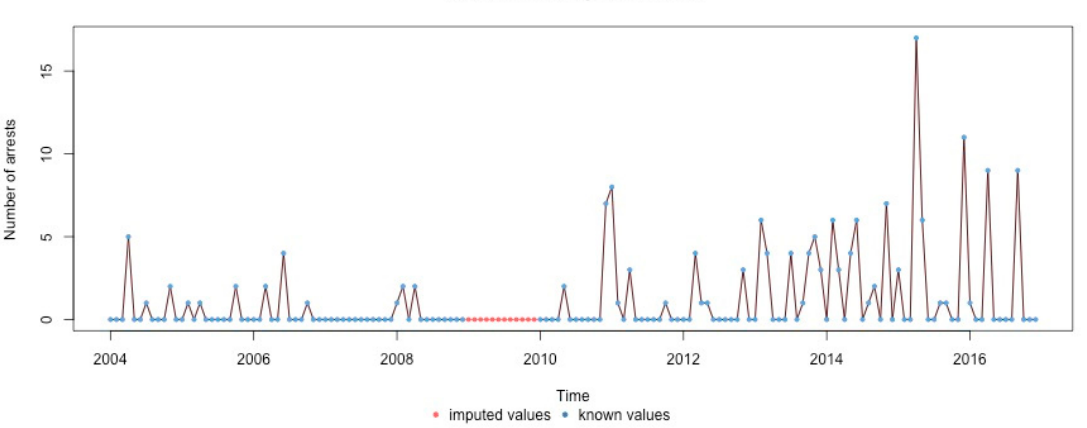
Figure A14. Methamphetamine-related organized Vietnamese nationals crime arrests 2004–2016 in the Czech Republic – imputed missing values.